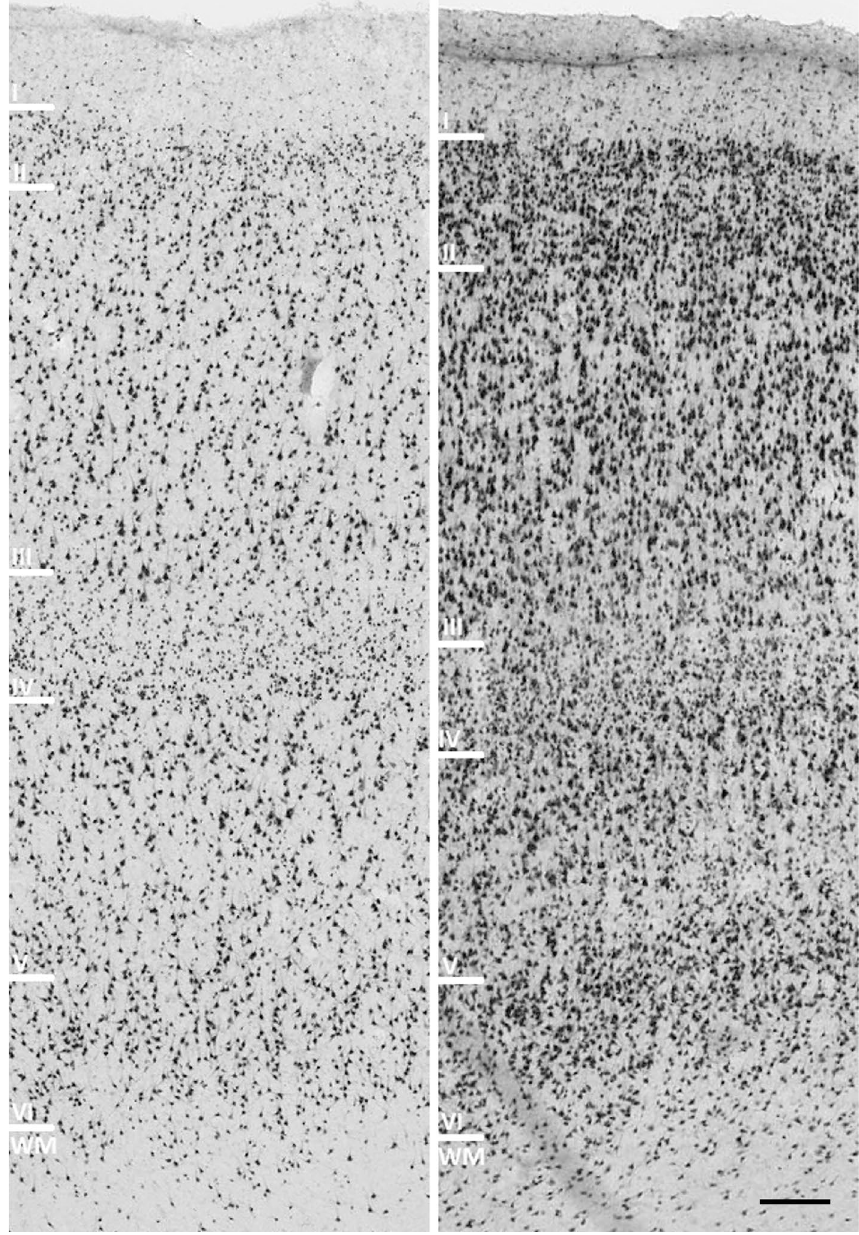
Figure 1. Histological slices stained with NeuN immunohistochemistry method showing varying neuronal morphology and cellular distribution across the layers of the cortex. The left image is taken from the dorsolateral part of the prefrontal cortex (thickness 10 µ m ) and the right image was taken from the orbital part of the prefrontal cortex (thickness 20 µ m ). Scale bar 100 µ m